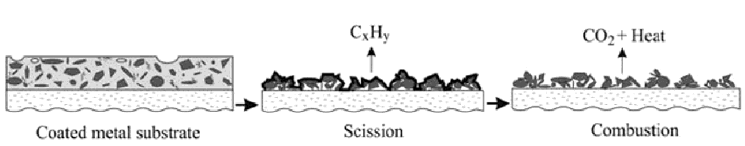
Figure 10. Evolution of the coating during the scission and combustion reactions in a thermal de-coating process. Reproduced with permission from [63], Springer Nature,